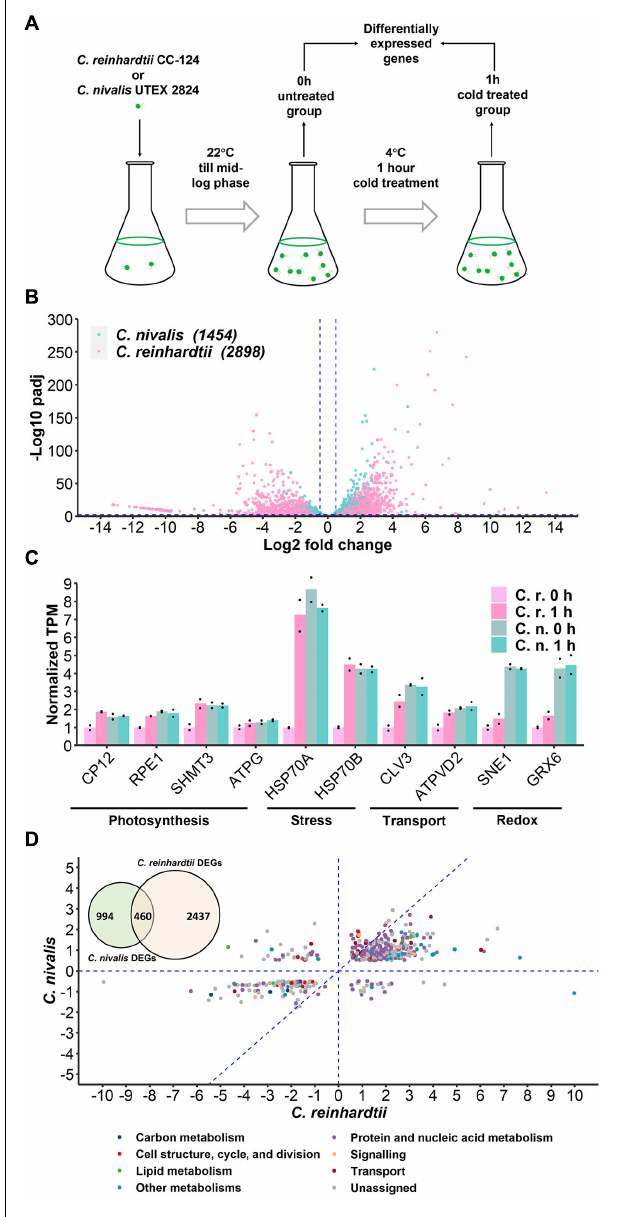
FIGURE 2 | Transcriptome of C. nivalis is relatively stable compared to C. reinhardtii . (A) Schematic of sampling for RNA-seq. Algal cells were grown at 22 ◦ C until mid-log phase (0 h) and transferred to 4 ◦ C immediately for 1 h. Samples at 0 h and 1 h were collected for RNA-seq and differential gene expression analysis. (B) Volcano plot of DEGs in C. nivalis and C. reinhardtii . The blue dashed lines indicate the threshold (fold change > 2 0 . 5 , adjusted P -value < 0.01) for DEGs filtering. The number of DEGs is indicated in parentheses after the species name. padj, FDR-adjusted P -value. (C) Transcripts per million reads (TPM) of ten conserved genes. TPM values were normalized to TPM value of C. reinhardtii at 22 ◦ C. The dots indicate the two replicates for each bar. (D) Venn diagram in the upper-left corner shows overlapping DEGs in C. nivalis and C. reinhardtii . Scatter plot shows fold changes of the overlapping DEGs in the two species separately and the category of DEG is indicated by color. The blue dash lines ( x = 0, y = 0, x = y ) partition the DEGs to clarify the relationship between fold changes in C. nivalis and C. reinhardtii . LFC, log 2 fold